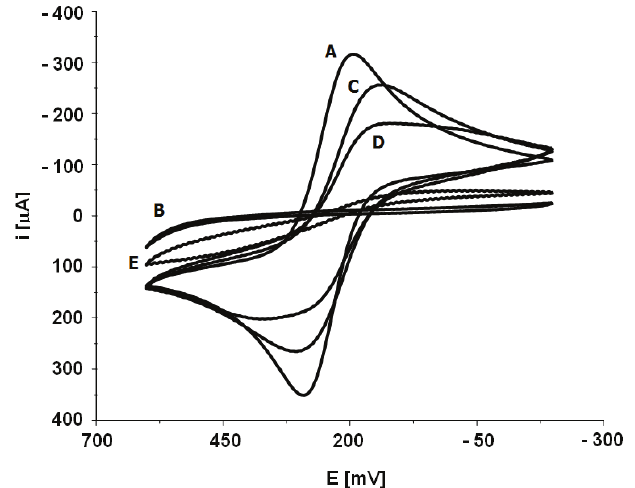
Figure 3. Cyclic voltammograms of (A) clean gold electrode surface; (B) 1,6-hexanedithiol/Au electrode; (C) gold nanorods/1,6-hexanedithiol/Au electrode; (D) F(ab’)/gold nanorods/1,6-hexanedithiol/Au electrode; (E) bovine serum albumin/F(ab’)/gold nanorods/1,6-hexanedithiol/Au electrode.